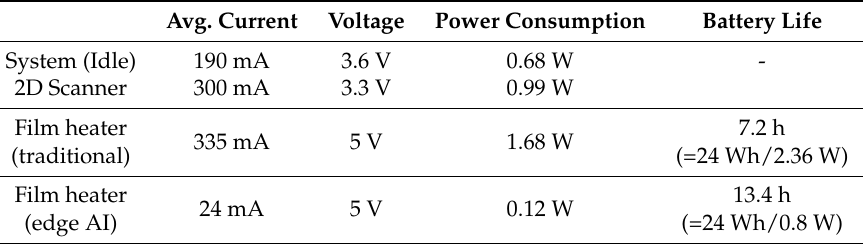
Table 7. Energy-saving effect of the edge AI in scanning